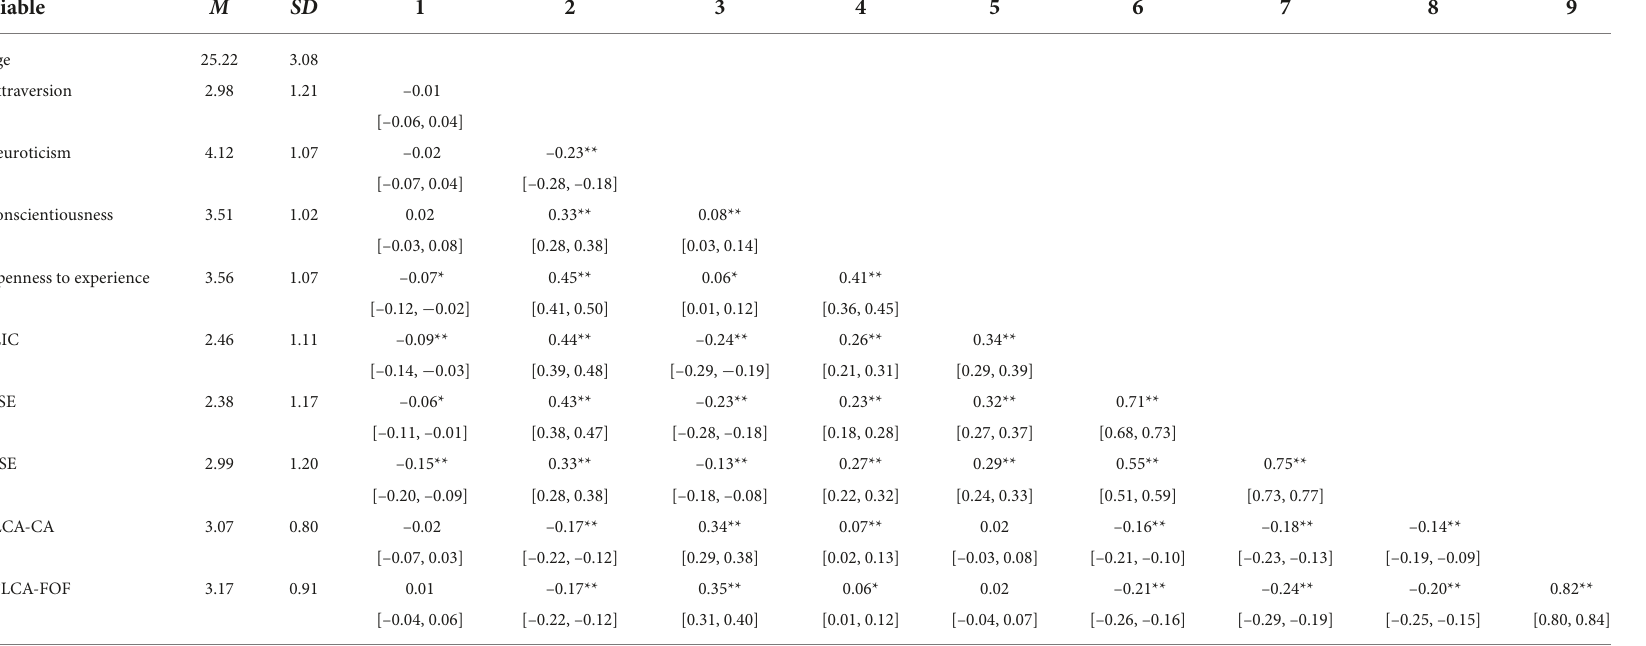
TABLE 4 Means, standard deviations, and correlations with confidence intervals. Variable